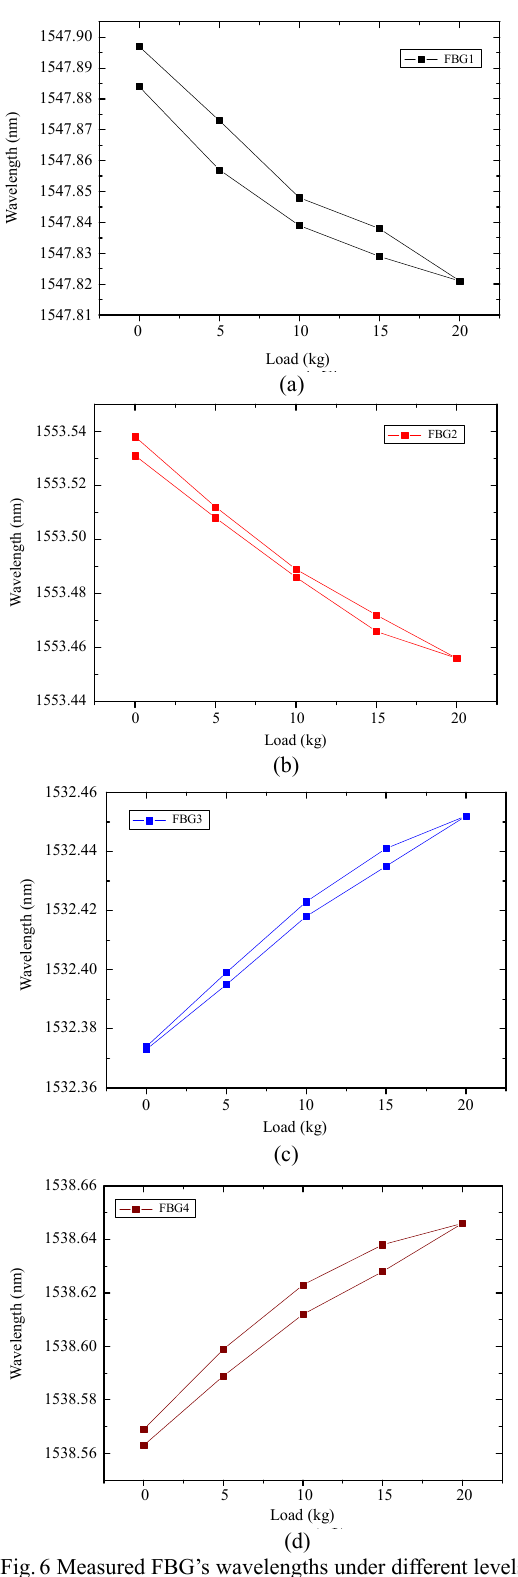
Fig. 5 Element results of glass panel under a concentrated load of 10 kg: (a) strain cloud diagraph in the x direction and (b) strain cloud diagraph in the y direction.